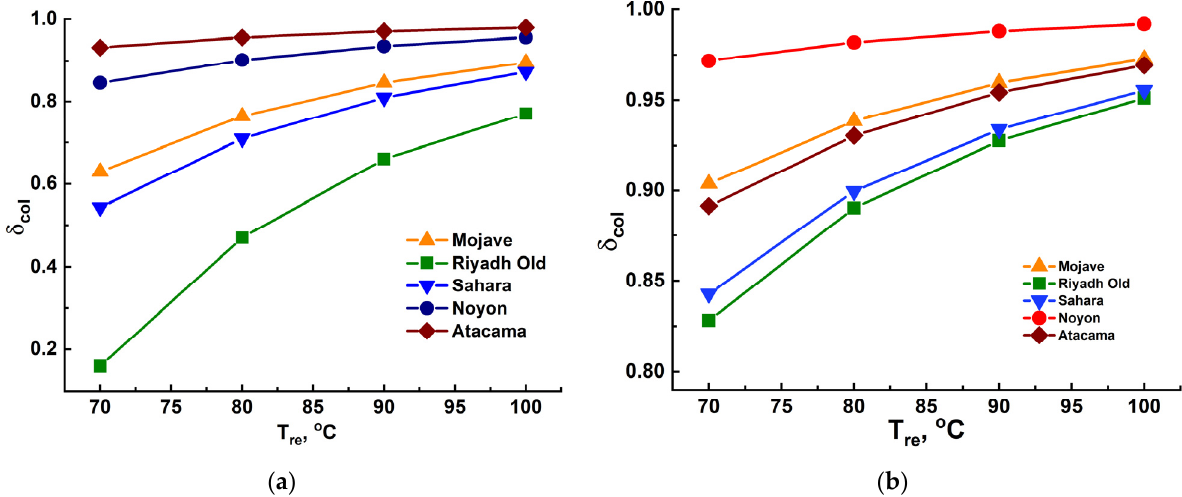
Figure 11. Effect of the regeneration temperature on the water-collection fraction δ col of the AWHA system based on MIL-160 during the dry ( a ) and humid ( b ) seasons, with the condenser cooled by the ambient air.